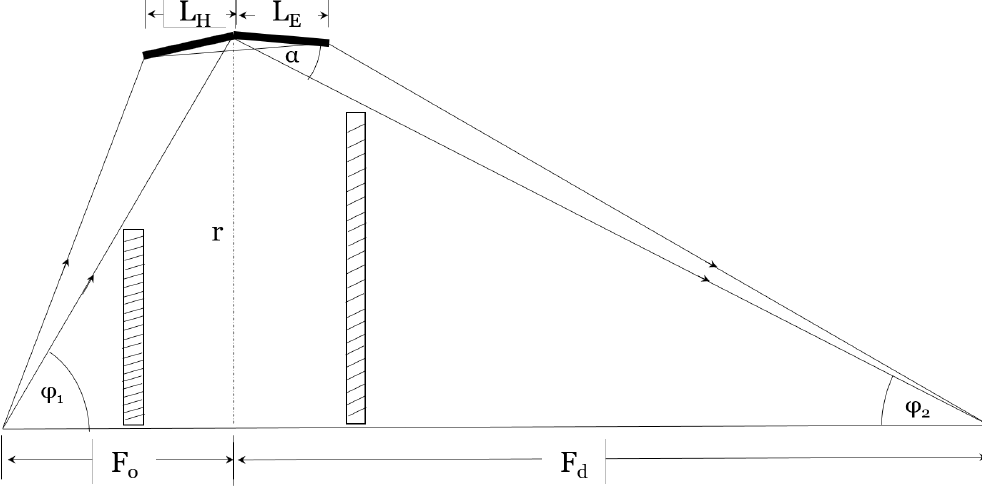
Figure 3. The geometry of the Wolter I objective. Rays from the optical axis are shown for